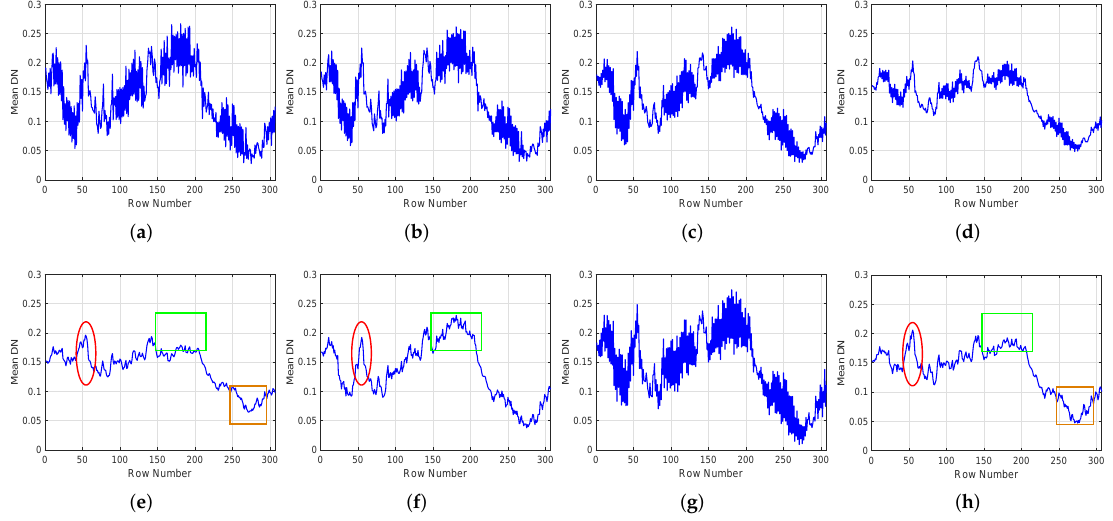
Figure 10. Horizontal mean profiles of band 109 by different algorithms in Urban dataset. ( a ) The observed; ( b ) BM4D; ( c ) LRMR; ( d ) LRTV; ( e ) 3DTVLR; ( f ) 3DCrTV; ( g ) LRRSDS; ( h )